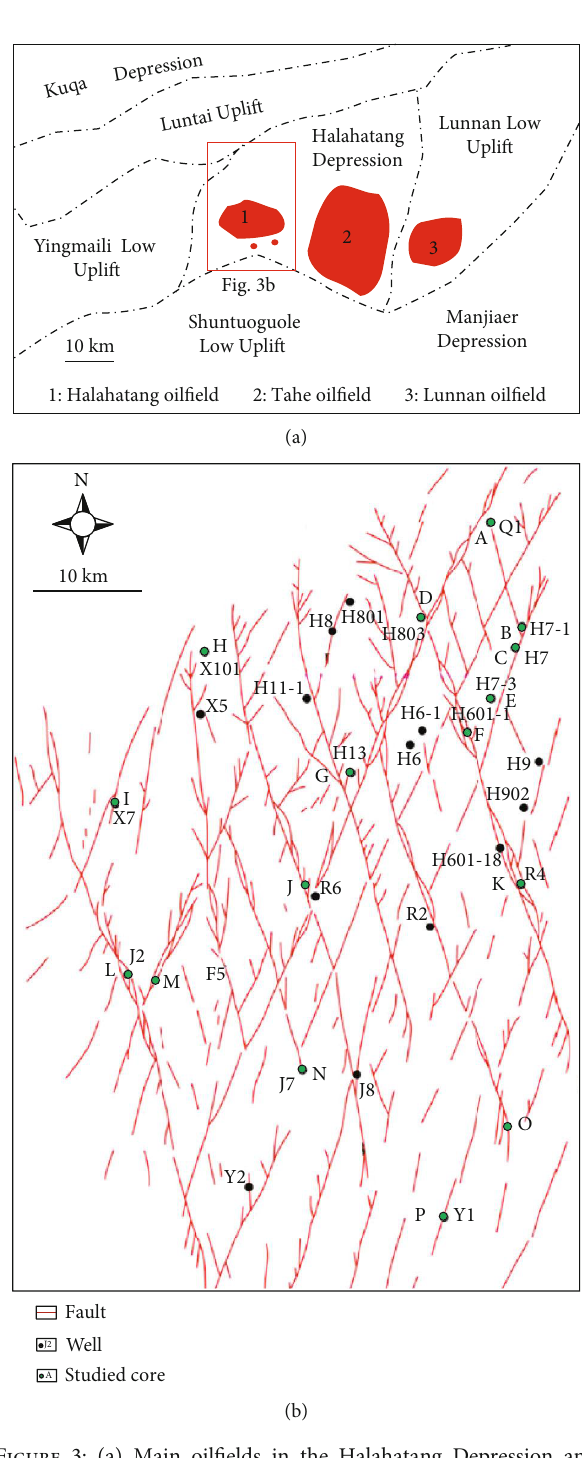
Figure 3: (a) Main oil fi elds in the Halahatang Depression and Lunnan Uplift (from Chang et al. [63]). Red square shows the area studied in cores. (b) Main fault traces in the Halahatang area (after Wu et al. [36]) and location of the studied cores (green